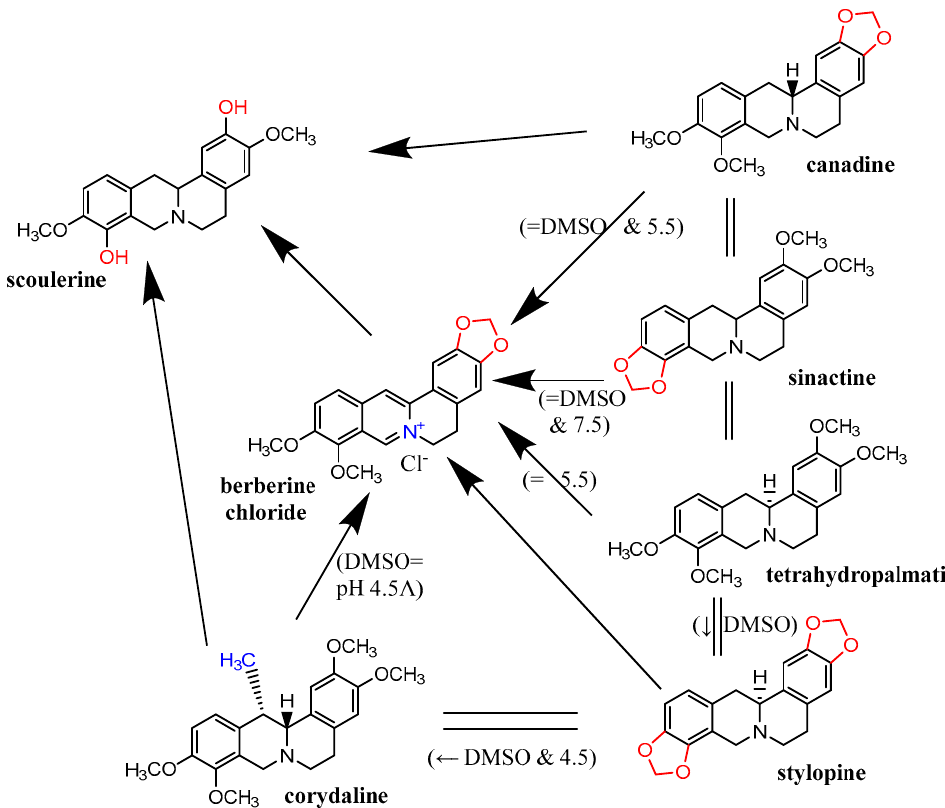
Figure 8. Graphical depiction of cupric-reduction potencies of tested protoberberine alkaloids. Ar- rows point to stronger reducing compounds. Exceptions to the general scheme are shown in paren- theses, including the conditions. Ʌ —corydaline was a more potent reduction agent at lower ratios, while berberine was more potent at higher ratios.